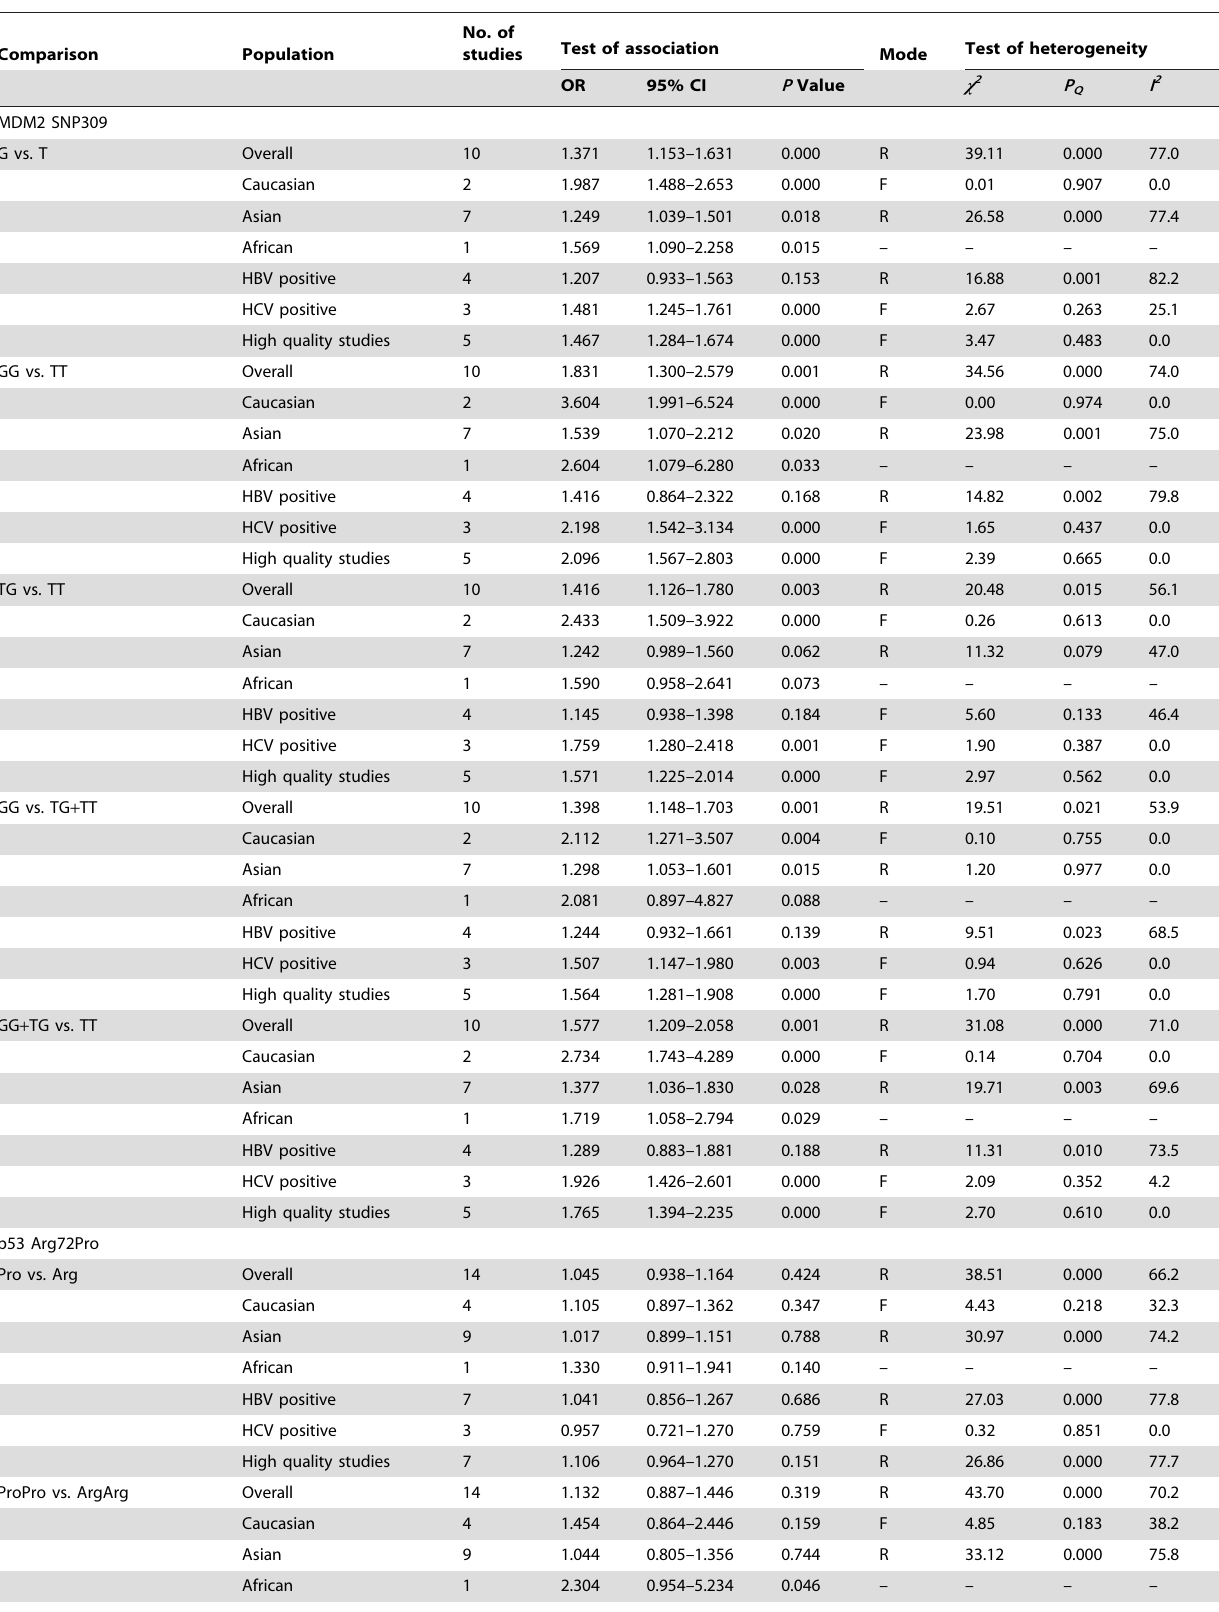
Table 3. Summary of the meta-analysis results for MDM2 SNP309 and TP53 Arg72Pro polymorphisms and HCC